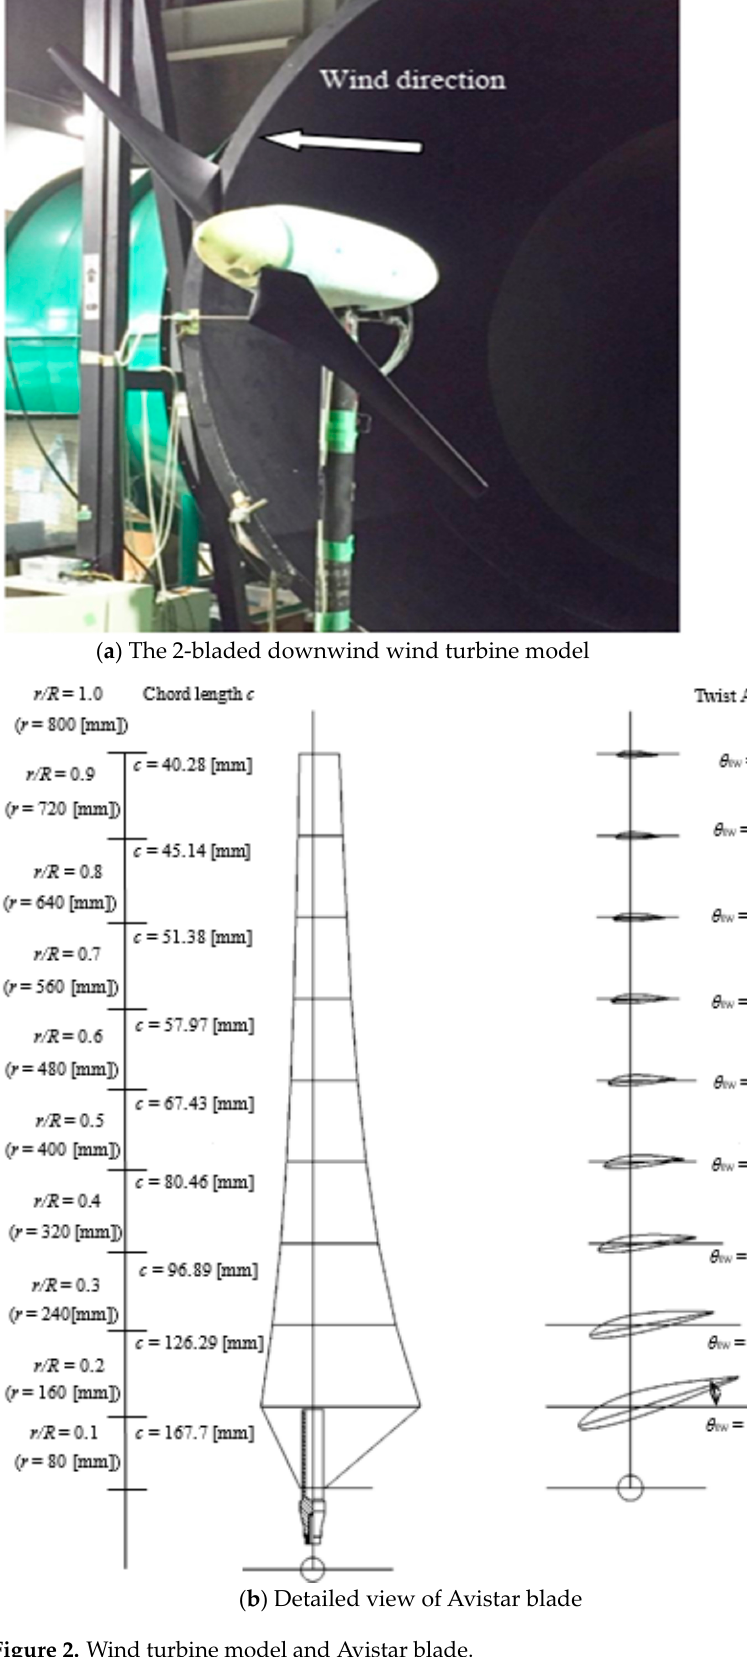
Figure 2. Wind turbine model and Avistar